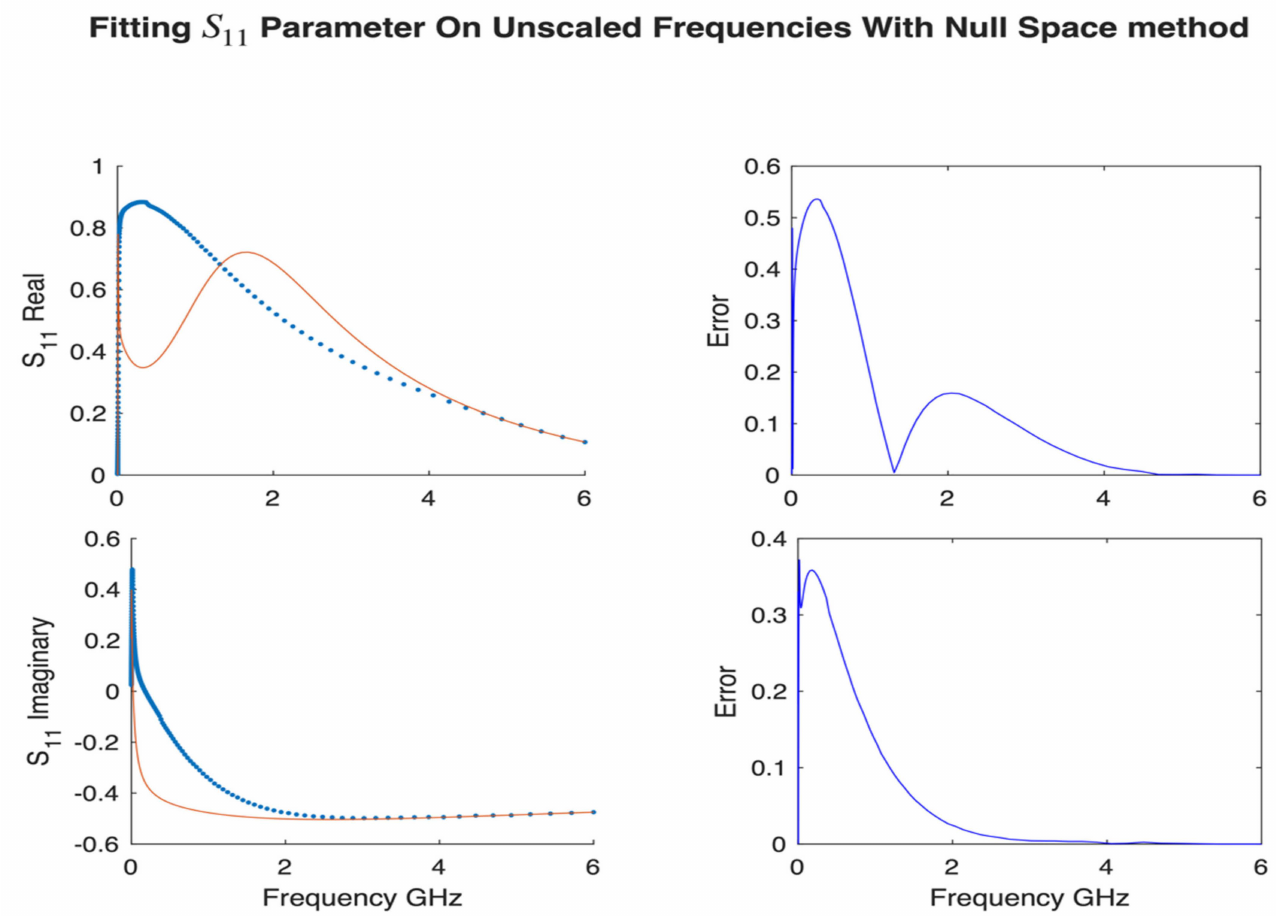
Figure 13. Left graphs show fitting functions via null space method without scaling frequencies s to interval [0, 1]. Error plots on right side suggest failure to obtain an accurate curve fitting without scaling